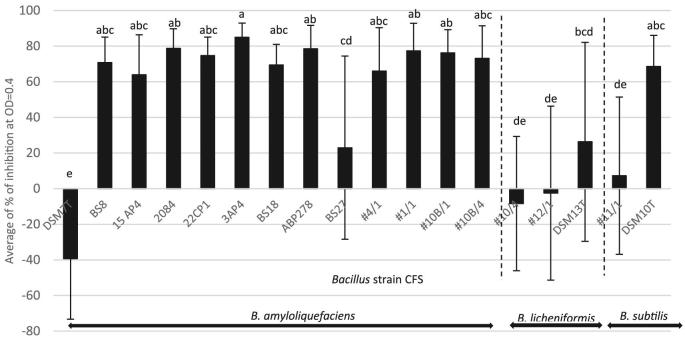
Mean percentage growth inhibition 1 of pathogenic E. cecorum isolates (based on 2 biological replicates; n = 9) by 18 Bacillus cell-free supernatants, measured at a time-point equivalent to that which produced an optical density of 0.4 in the positive control.1 Defined as the percentage reduction in pathogen isolate growth in the experimental sample compared with that in the respective PC sample (containing pathogen in BHI medium but no Bacillus CFS), with growth being measured as biomass (absorbance (OD)), not as CFU, and being determined at the time-point equivalent to that producing an OD of 0.4 in the PC. Thus, 90% inhibition would mean a 90% reduction in growth (biomass). a, b, c, d, e Bars with no common letters are significantly different (P < 0.01).